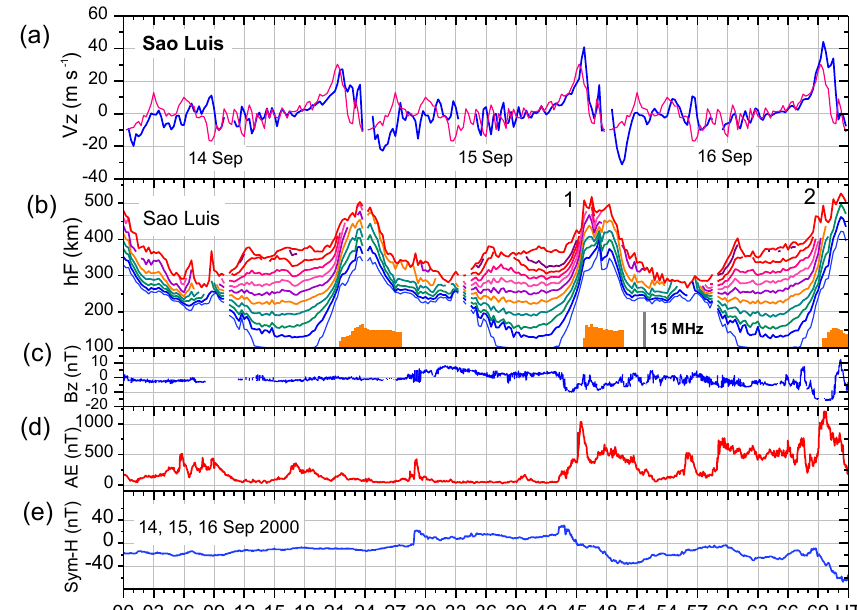
Figure 2. Panels from top to bottom show variations in the following parameters during 14–16 September 2000: (a) the vertical drift ( V z ) obtained as mean of those calculated as d h F / d t at four plasma frequencies, 4MHz, 5, 6, and 7MHz (blue curve) and a representative quiet day V z variation (pink curve); (b) the F layer heights at fixed plasma frequencies at 1MHz interval from 3 to 12MHz (color coded), and the fop parameter (in orange) indicative of the spread F intensity, in MHz (scale inset); and (c) Interplanetary magnetic field component B z , (d) the auroral activity index AE; and (e) the Sym-H/Dst index at 1min interval. Please note that the UT on the x axis is cumulative with increasing number of